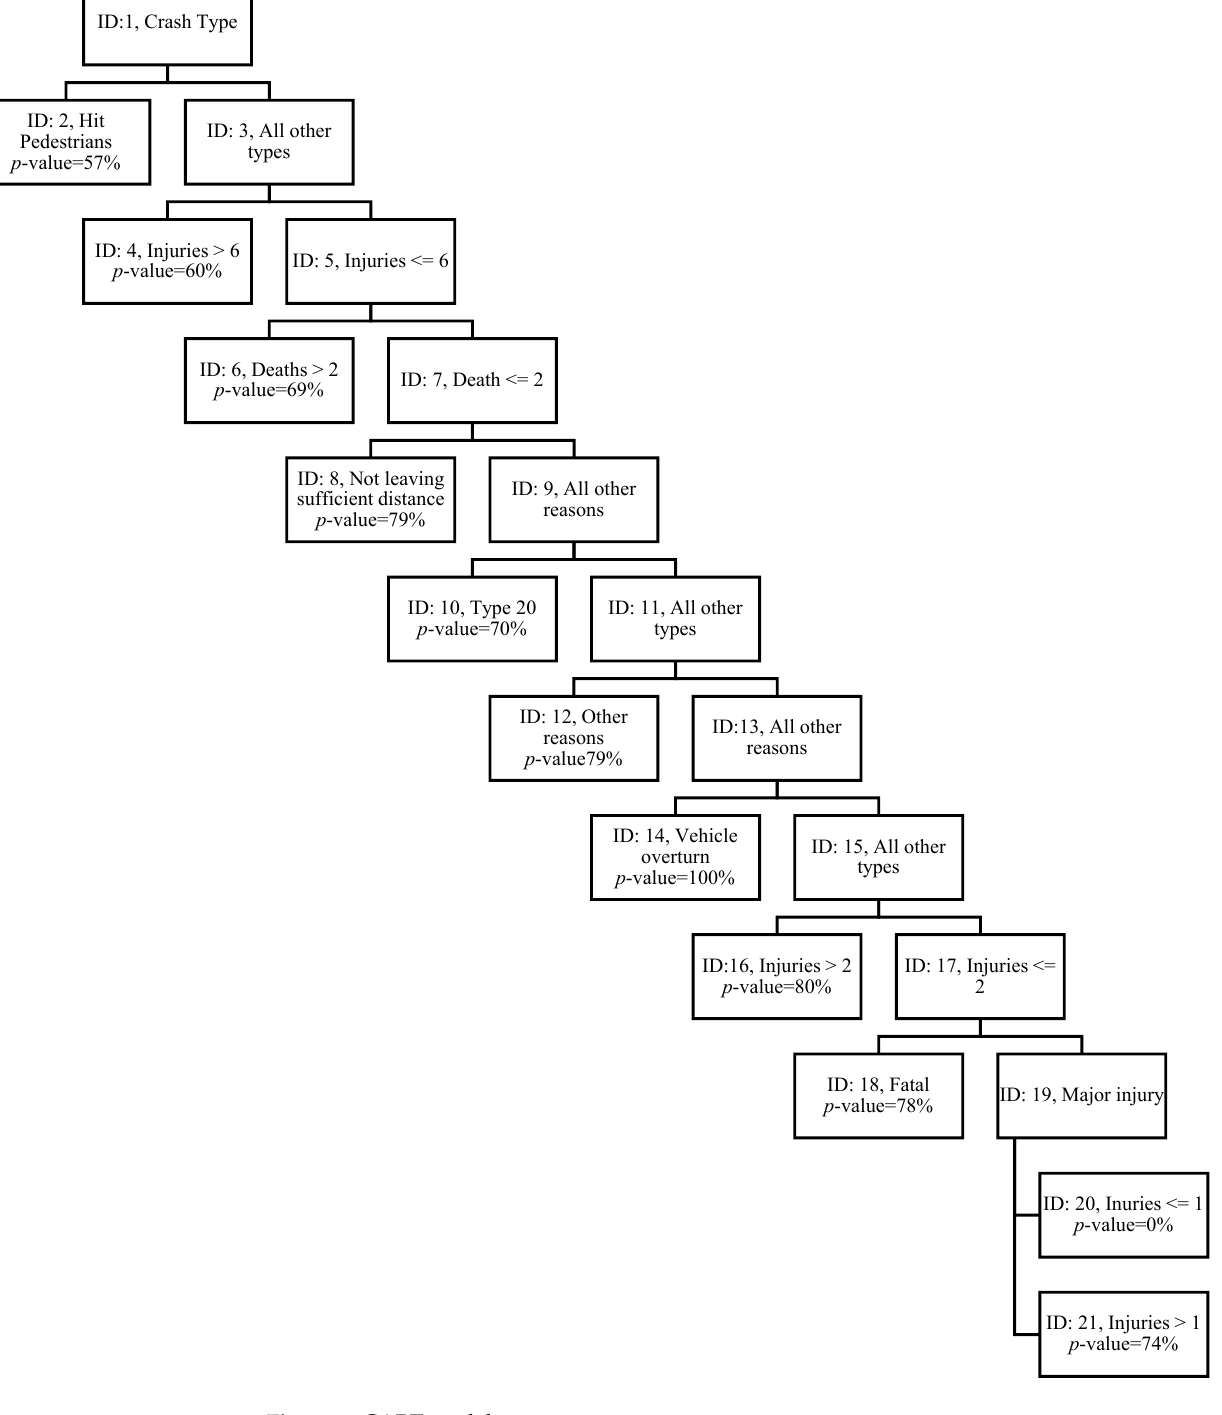
Figure 7. CART model.